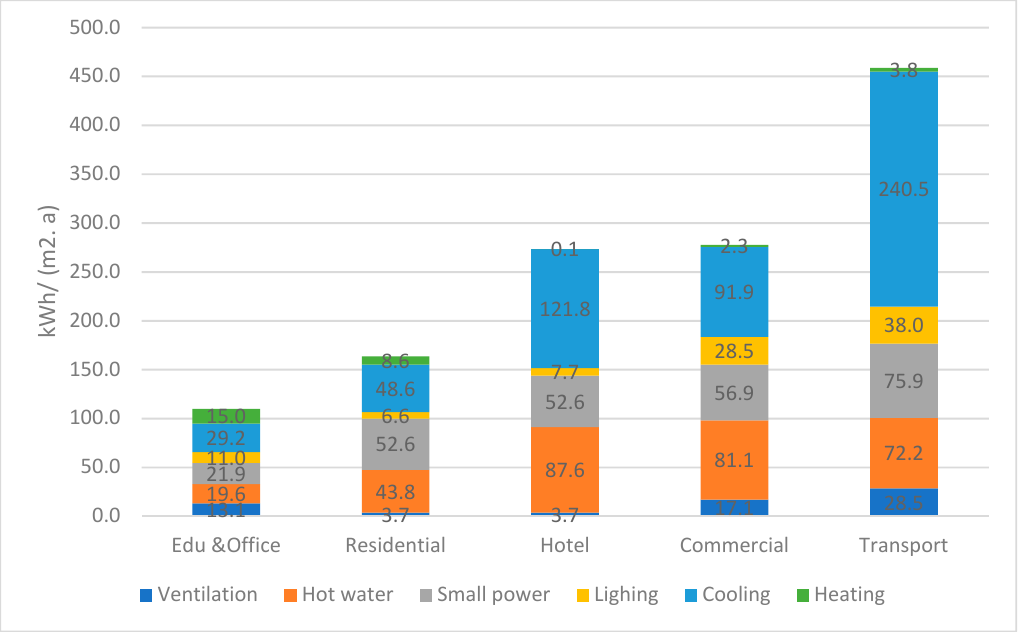
Figure 11. Energy demand by components of the five building types.